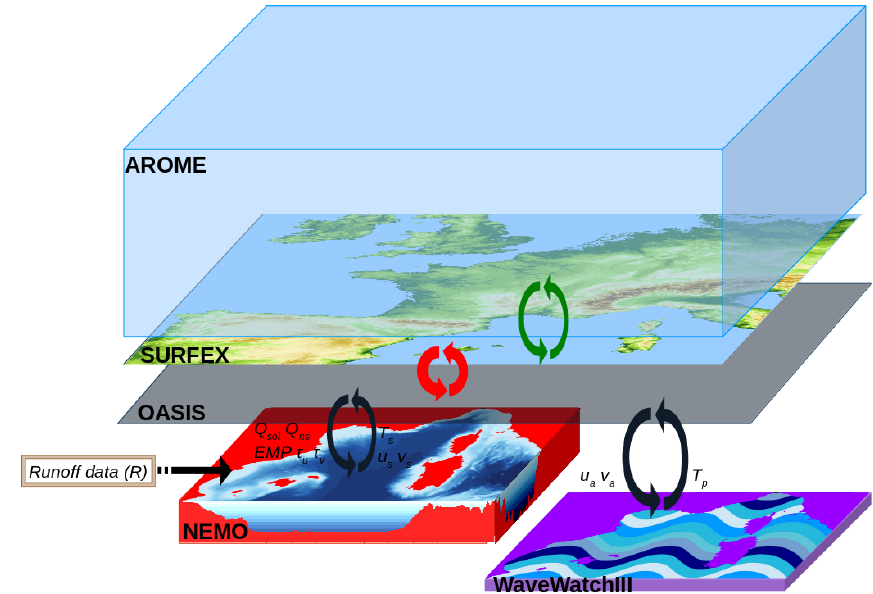
Figure 1. The NEMO-AROME-WW3 coupled architecture and domains illustrated by orography (of the AROME-France domain in the SURFEX “area”) and the NWMED72 bathymetry (in the NEMO box). The SURFEX-OASIS interface (red arrows) is detailed in Voldoire et al. (2017), and the AROME-SURFEX links (green arrows) are described in Masson et al. (2013) and Seity et al. (2011). See text and Table 1 for the exchanges involving NEMO and